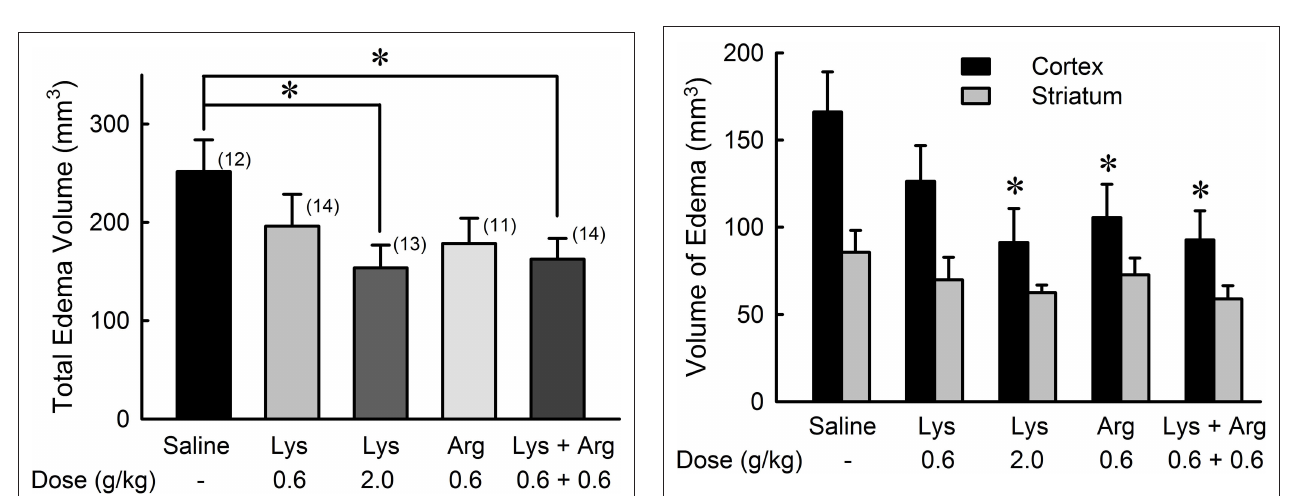
FIgure 2 | reduction of whole cerebral edema volume by oral administration of lysine (Lys) and/or arginine (Arg) in MCAO rats. Administration of lysine alone at high dose (2.0 g/kg), or combined administration of lysine and arginine at low doses (0.6 g/kg each) significantly suppressed whole cerebral edema volume. Numbers between parentheses represent number of experiments. * p < 0.05, significance compared to saline-treated control groups by ANOVA followed by Fisher’s PLSD test.